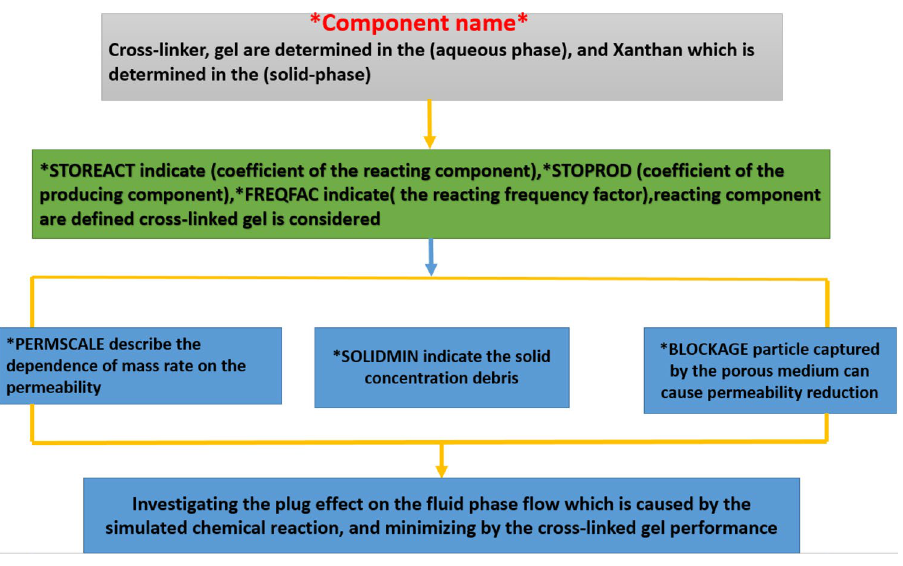
Figure 4. Keywords description of the cross-linked gel reaction model CMG STARS 2017.10 URL: https:// www. cmgl.